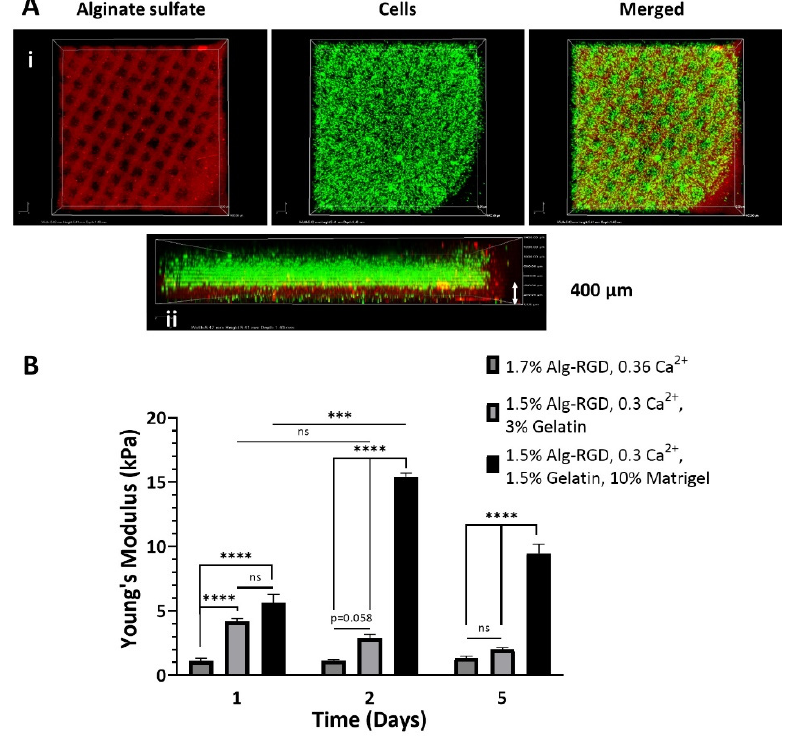
Figure 5. Three-dimensional bio-printing of cardiac patches. ( A ) Confocal images of XY (i) and reconstructed YZ (ii) planes of the two-compartment, 3D bio-printed cardiac patch. Red—Alginate sulfate; Green—fluorescently labeled cells. ( B ) Young’s modulus of 3D bio-printed cardiac patches over time, using different core bioink. Data are mean ± SEM, n = 3–4, *** p < 0.001, **** p < 0.0001, Tukey’s test, two-way